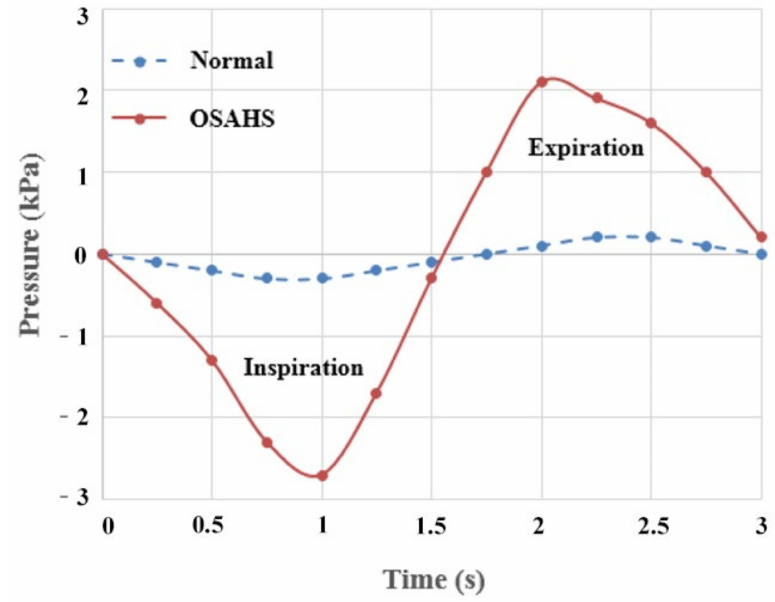
Figure 5. The time-history curves of cavity pressure of the OSAHS patient during